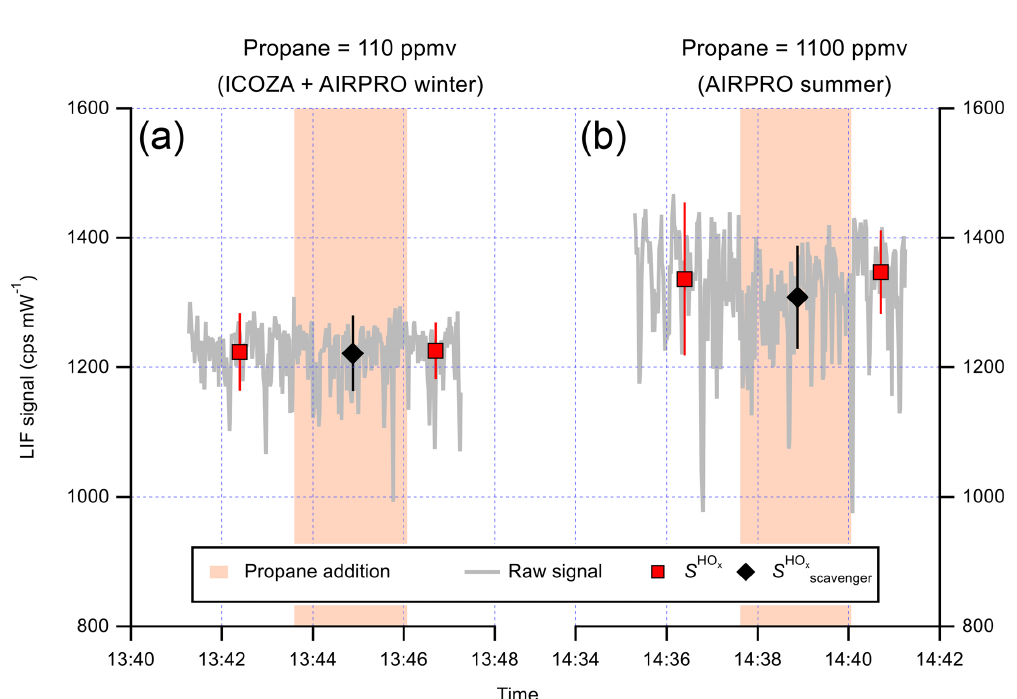
Figure 6. Time series of the LIF signal during internal OH removal experiments. The raw 1s data are given by the grey line. NO was continuously added to the FAGE cell during these experiments (to form OH internally), and points where propane was added to the IPI flow tube are indicated by the orange-shaded panels, with the corresponding signal averages ( ± 1 σ ) shown as markers (see text for details). The first experiment (a) corresponds to the propane mixing ratio used for ICOZA, while the second (b) corresponds to that used for AIRPRO. The results of the internal OH removal experiments are summarised in Table